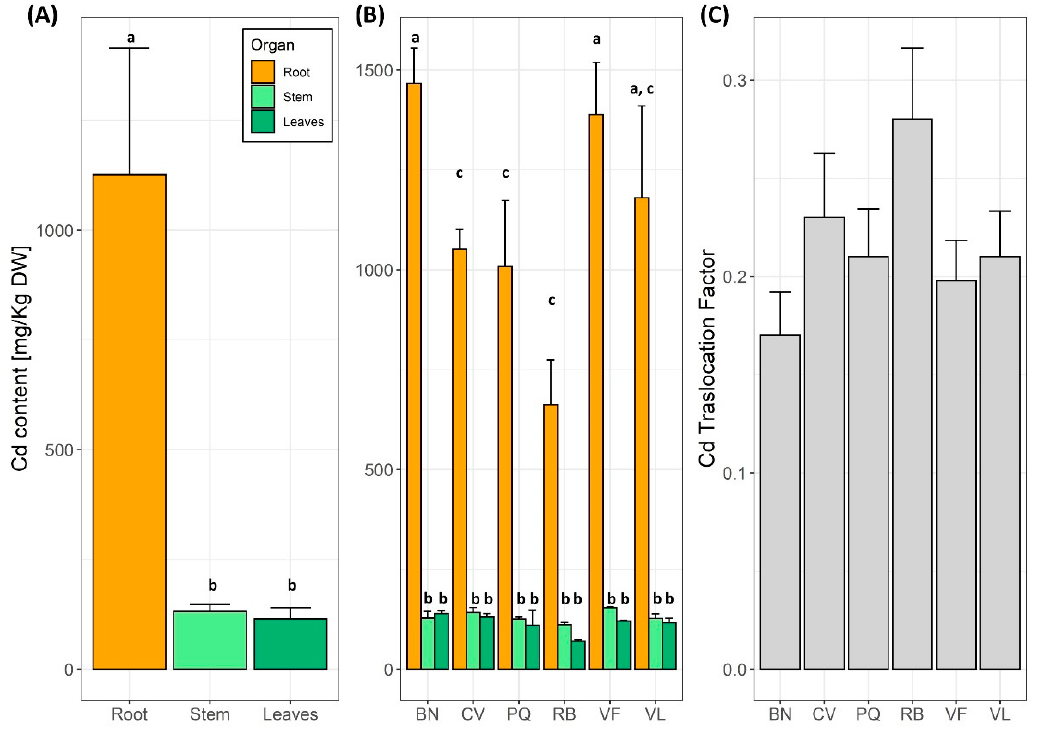
Figure 3. Cd content ( A , B ) and translocation factor ( C ) for eggplants grown with 5 µ M Cd. Cd content in the three plant organs is showed for all the cultivars together ( A ) and for each investigated cultivar ( B ): BN = Bellezza Nera; CV = Cima Viola; PQ = Hybrid F1 Purple Queen; RB = Rotonda Bianca Sfumata di Rosa; VF = Violetta di Firenze; VL = Violetta Lunga. Error bars represent the standard deviation. Different letters indicate significant statistical differences ( p ≤ 0.05). Table 2. Bioaccumulation index and standard deviation (sd) for the six investigated eggplant cultivars.